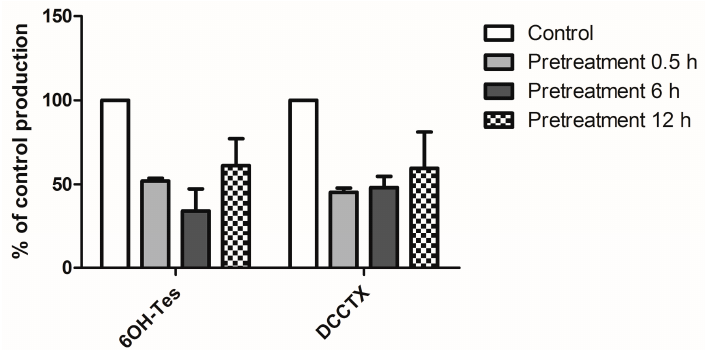
Figure 5. Effect of Gom A pretreatment on CYP3A activity in rat liver microsomes. Gom A was pretreated at single-dose of 20.8 mg/kg (50 µmol/kg). The rat livers were collected 0.5 h, 6 h and 12 h after Gom A administration. Production of 6OH-Tes and DCCTX were determined. Each point represents the mean of triplicate determinations.